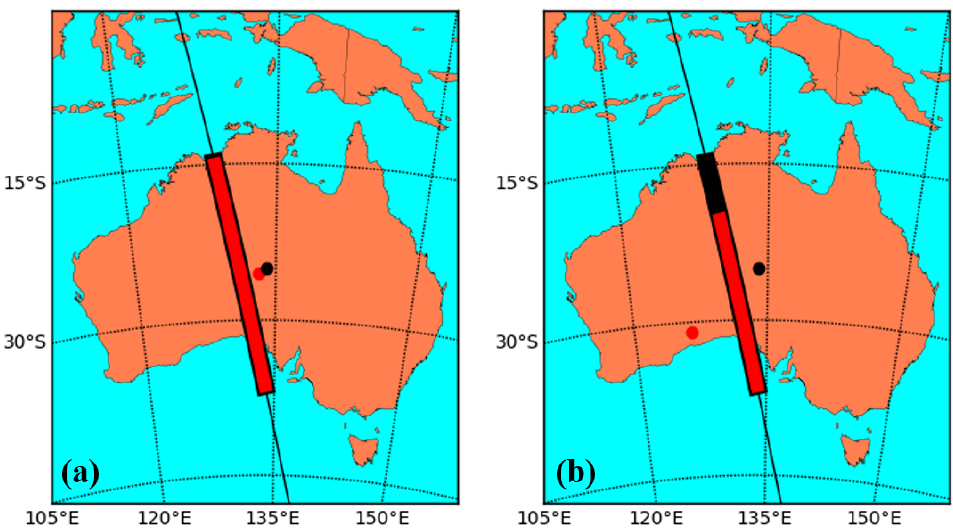
Figure 3. QKD transmission window coverage for laser terminals ( a ) 100 km away and ( b ) 1000 km away from the QKD ground station. The black dot represents the QKD ground station, and the black bar represents the QKD transmission window. The red dot represents an example location for the laser terminal, and the red bar shows the portion of the QKD transmission window that the satellite is visible to the laser terminal from this